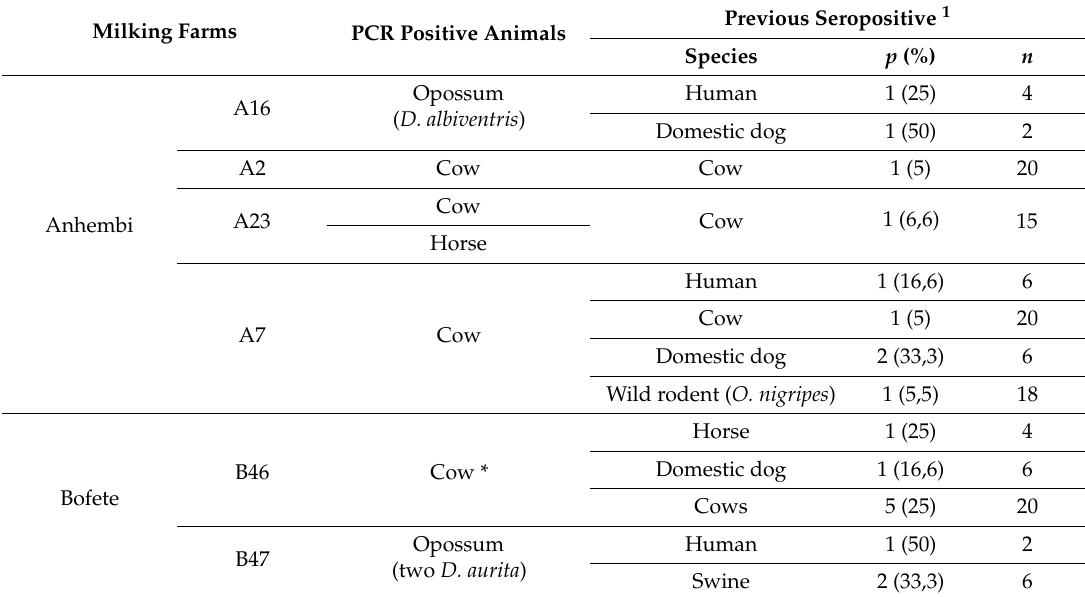
Table 4. Farms in which VACV DNA were detected by PCR in blood samples and previous seropositivity of animals and humans from these DNA positive farms.